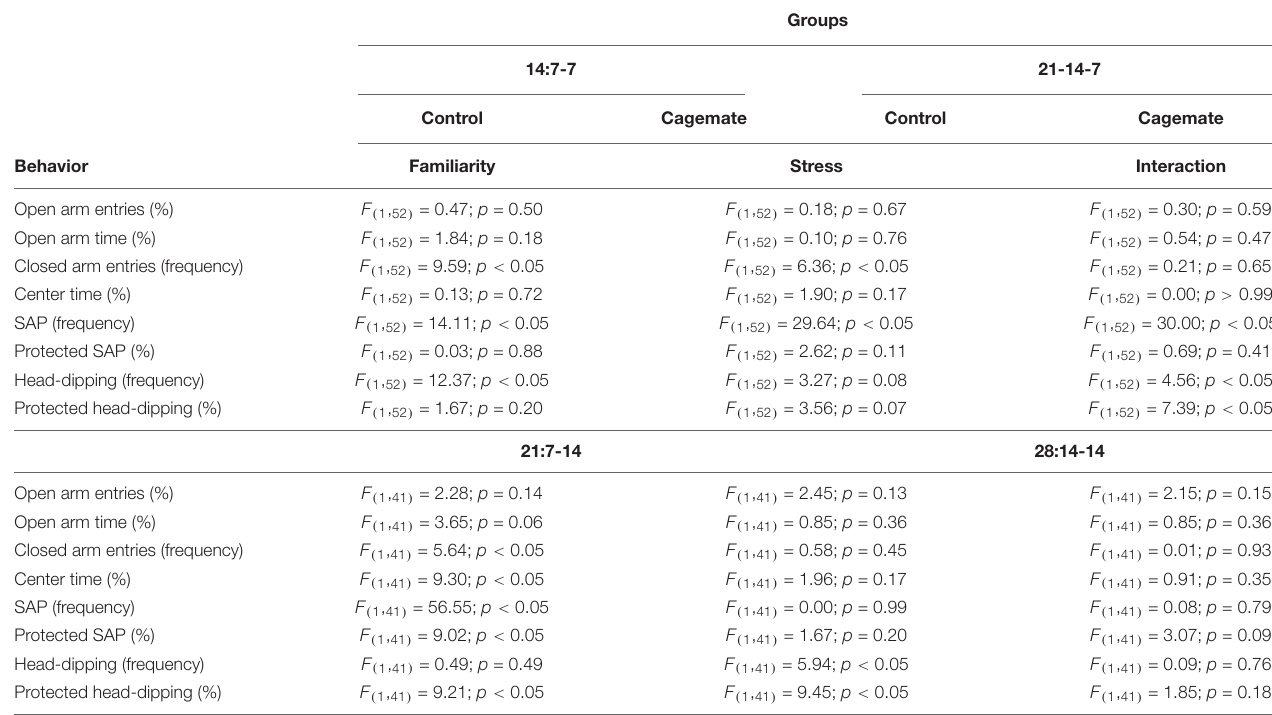
TABLE 1 | Two-way ANOVA for anxiety-like behavior evaluated in the elevated plus